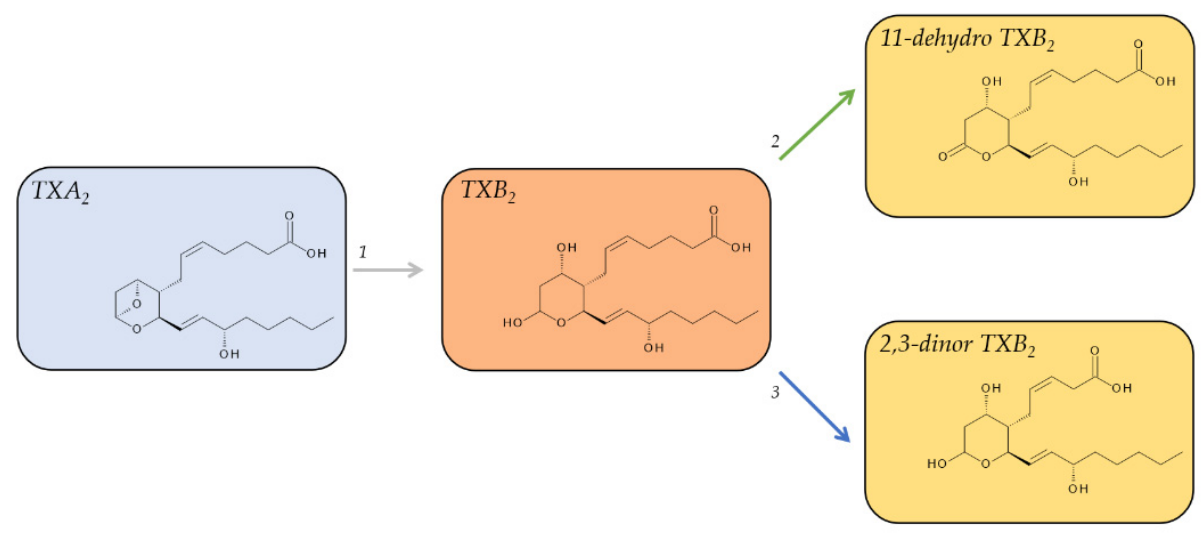
Figure 5. Major metabolic pathway of TXA 2 . Metabolites on a red background are regarded as major plasma metabolites; metabolites on a yellow background are major urinary metabolites. The grey arrow indicates non-enzymatic decomposition, the green and blue arrows oxidation reactions. 1, non-enzymatic degradation; 2, 11-hydroxy Thromboxane Dehydrogenase (EC 1.2.1.3); 3, enzymatic β‐ oxidation.